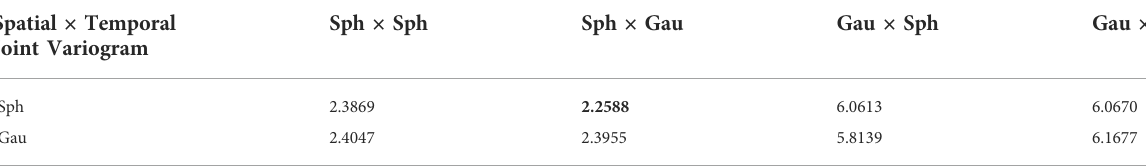
TABLE 1 RMSE obtained with the leave-one-out accuracy estimation for the different combinations of spatial, temporal and joint variograms. The smaller the error, the better the quality of the interpolation. The best model is highlighted using bold font. Spatial × Temporal Joint Variogram